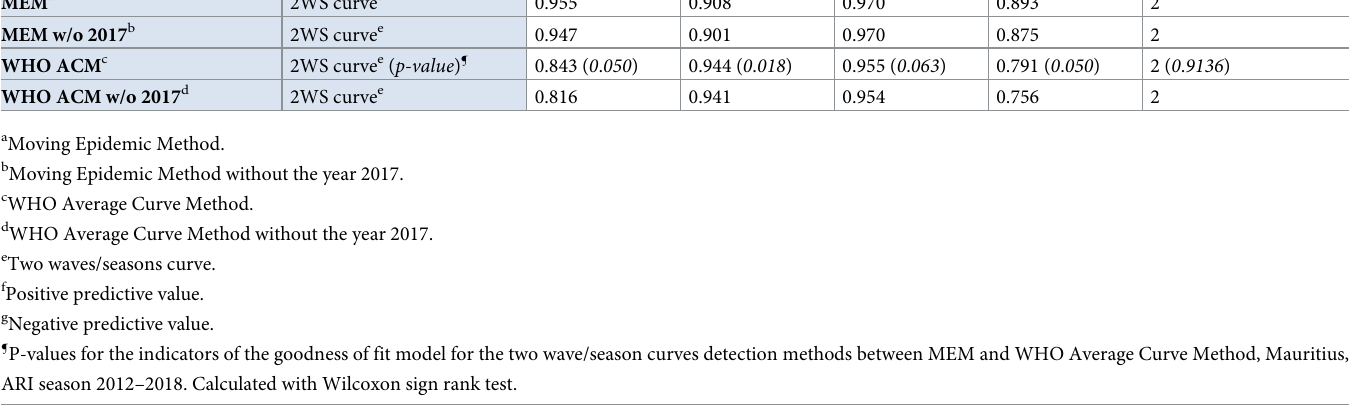
Table 2. Comparing the indicators of the goodness of fit model for the two wave/season curves detection methods between MEM and WHO Average Curve Method, Mauritius, ARI season 2012–2018. Epidemic detection methods Waves detection model